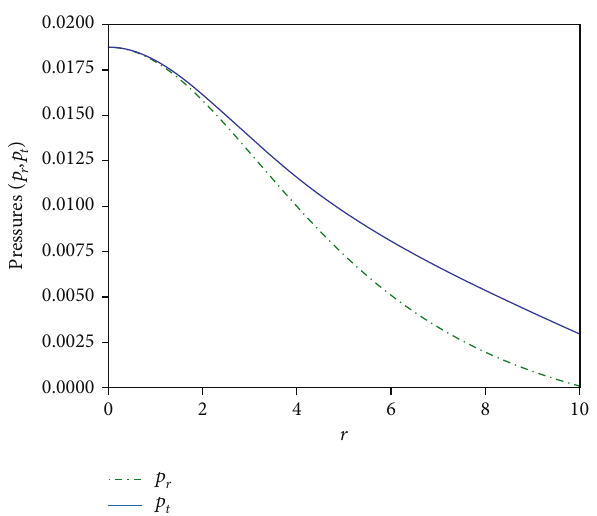
Þ and tangential pressure ð p r